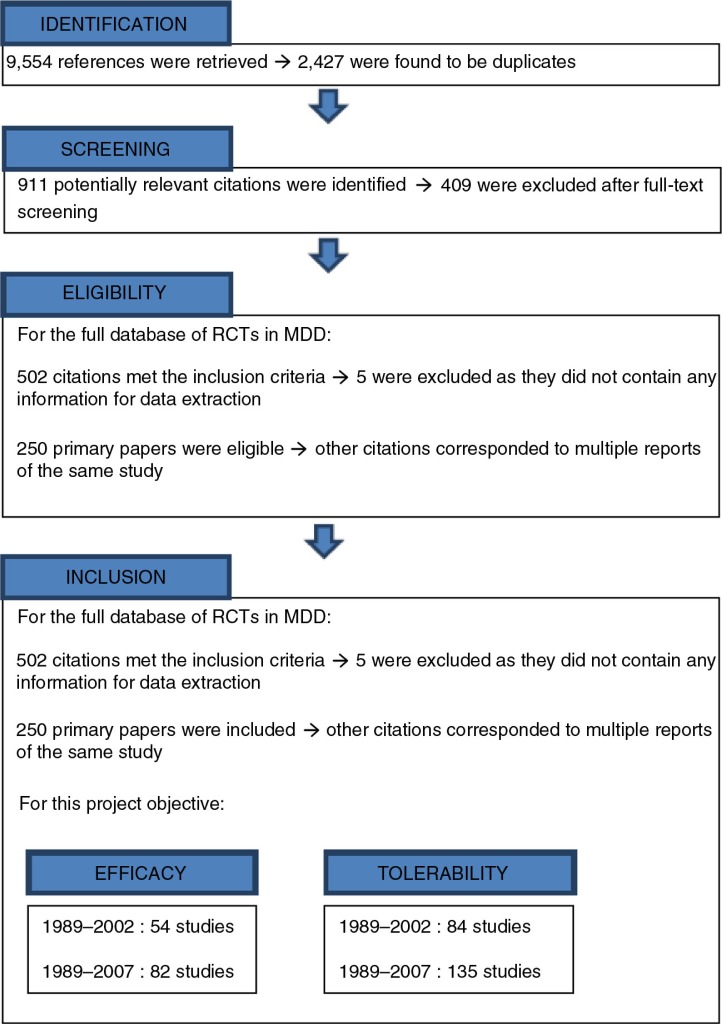
Study flow chart.